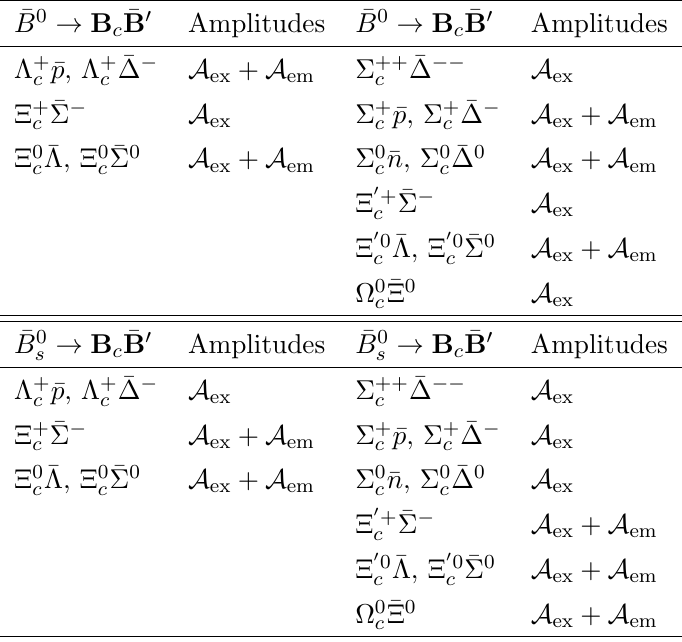
B c (cid:22) B 0 decays, where !